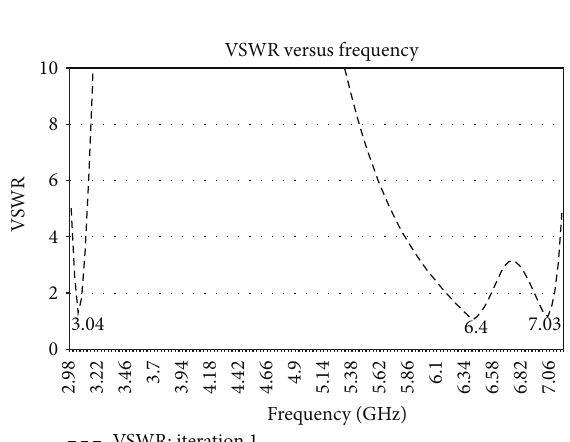
Figure 6: 𝑆 11 versus frequency (GHz).